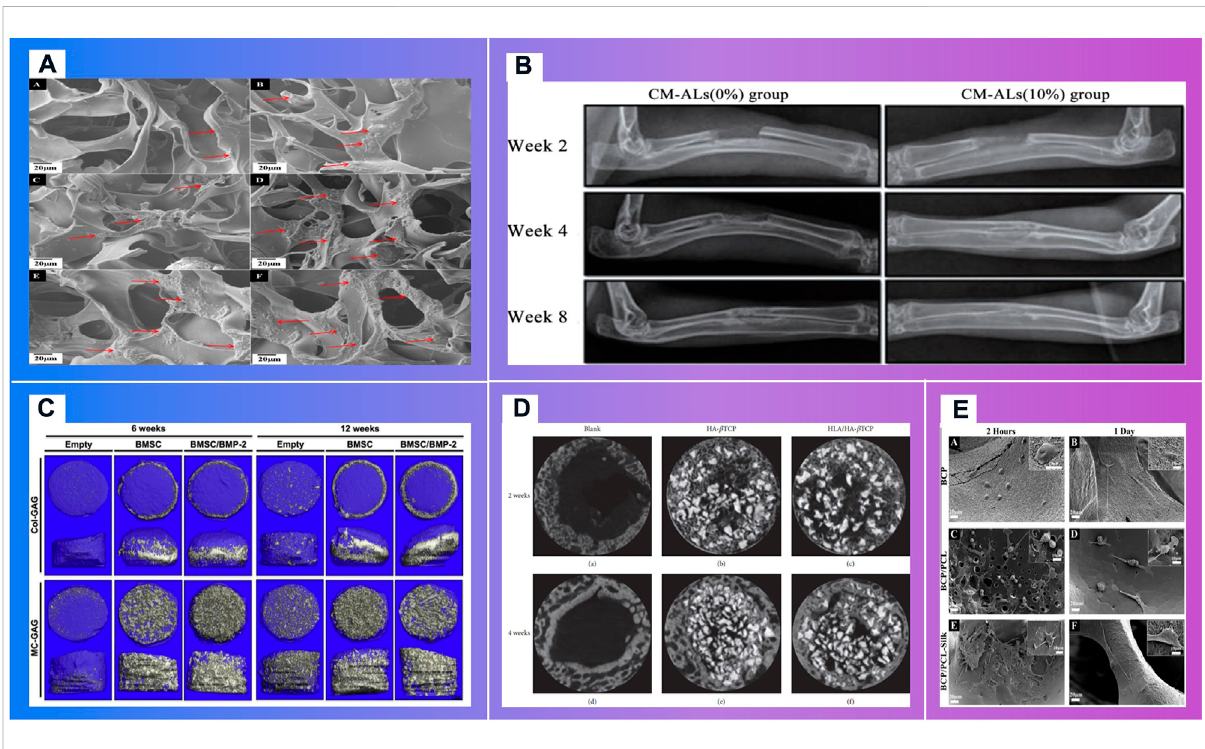
FIGURE 8 Bioactive materials demonstrating the osteoblast migrations. (A) . In vitro mineralization on mCT scanning of BMSCs cultured on Col-GAG and MC-GAG scaffoldsin the absence and presence of BMP-2 (Makvandiet al., 2020) (B) . In vitro mineralization on mCT scanning of BMSCs cultured on Col-GAG and MC-GAG scaffolds in the absence and presence of BMP-2 (Ren et al., 2016) (C) . X-ray analysis of new bone formation in CM-ALs (0%) and CM-ALs (10%) implanted groups (Wu et al., 2017). (D) . Micro-CT images of the arti fi cial defects at weeks 2 and 4. (Chang et al., 2016) (E) . Morphology of cultured HOB on (A,B) BCP, (C,D) BCP/PCL and (E,F) BCP/PCL – silk scaffolds after 2 and 24 h (Roohani-Esfahani et al.,